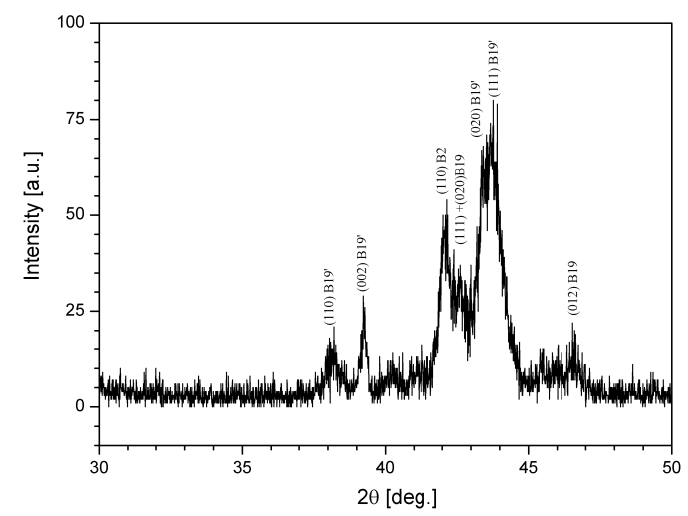
Figure 6. XRD record of the sputtered Ti-Ni-Cu film.